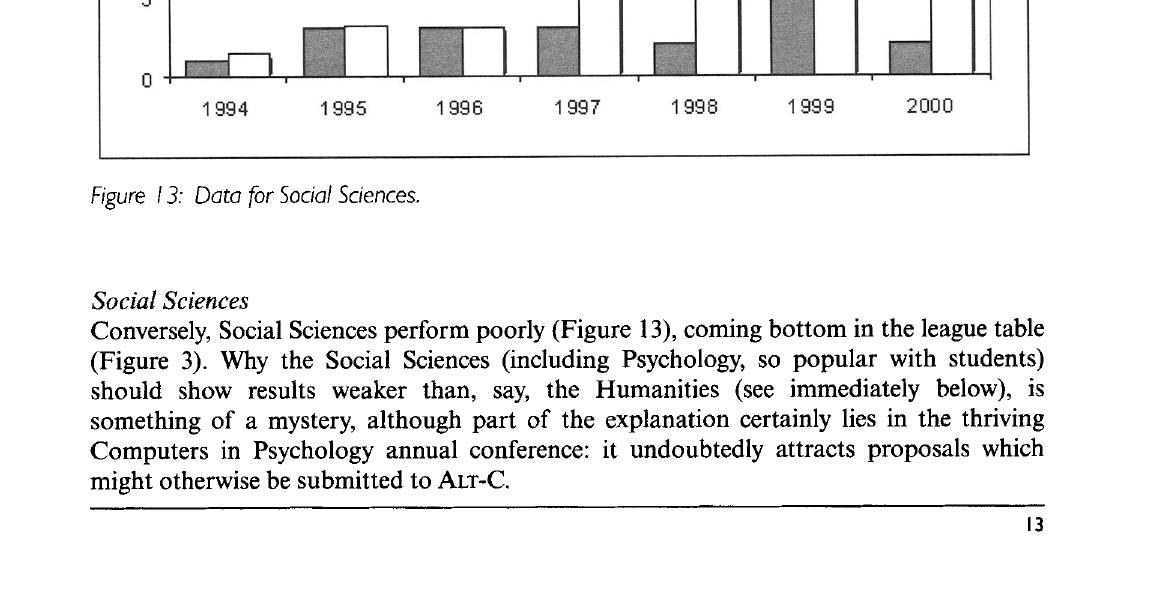
Figure 13: Data for Social